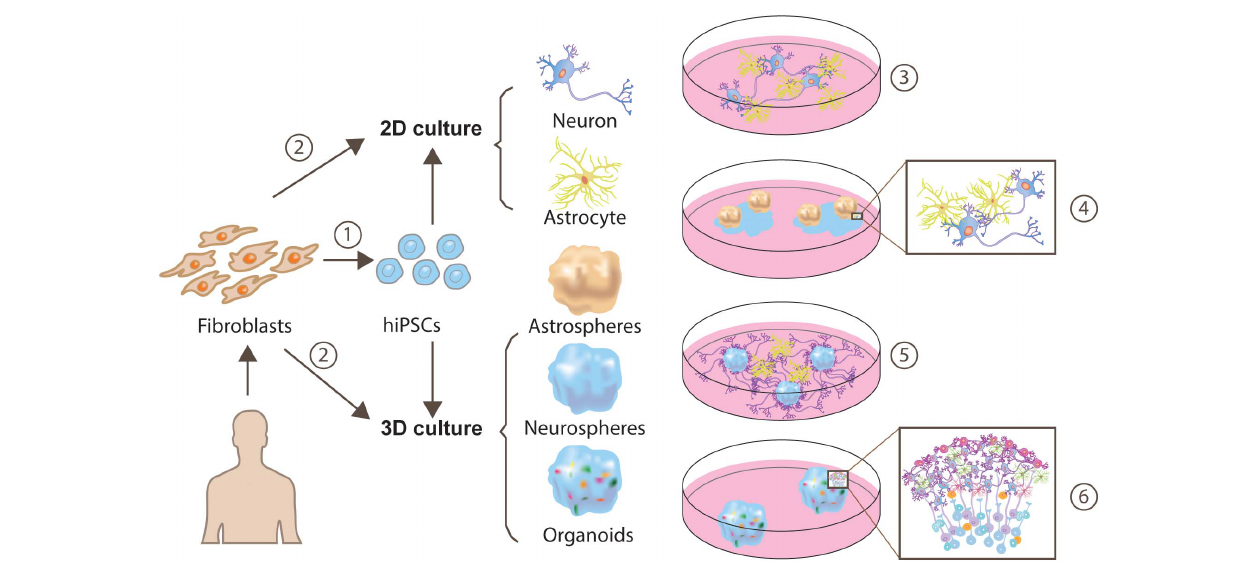
FIGURE 2 | Approaches for generating human iPSC-derived neuron-astrocyte co-cultures. Human fibroblasts can be reprogrammed to a pluripotent state and yield cells exhibiting neuron or astrocyte features through monolayer generation (Tcw et al., 2017; Lundin et al., 2018) or 3D generation (Sloan et al., 2017) (cid:192) . Besides, a more direct and time-saving way is direct conversion via transcription factors (TF), or expressing a minimal set of cell-lineage-specific TF in fibroblasts (Caiazzo et al., 2015) (cid:193) . These neuron-astrocyte co-cultures can be assembled in multiple ways, such as 2-dimensional (2D) neuron-astrocyte co-culture (cid:194) , plating astrospheres into 2D neuron culture (cid:195) (Krencik et al., 2017), plating astrocytes into 3D neurospheres culture (cid:196) (Krencik et al., 2017) or cortical organoids (cid:197)